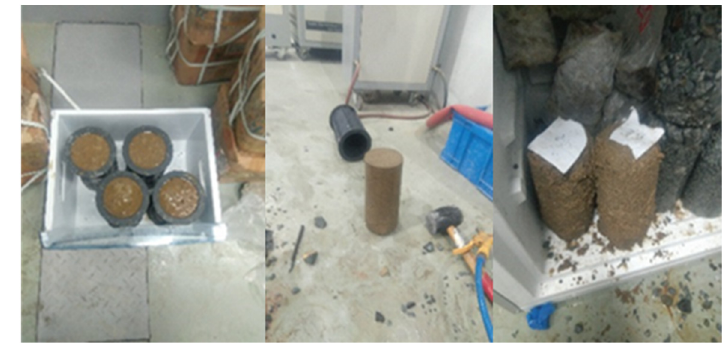
Figure 1. Preparation of sand specimen. Table 1. Properties of specimens (N.M. represents no measurement).